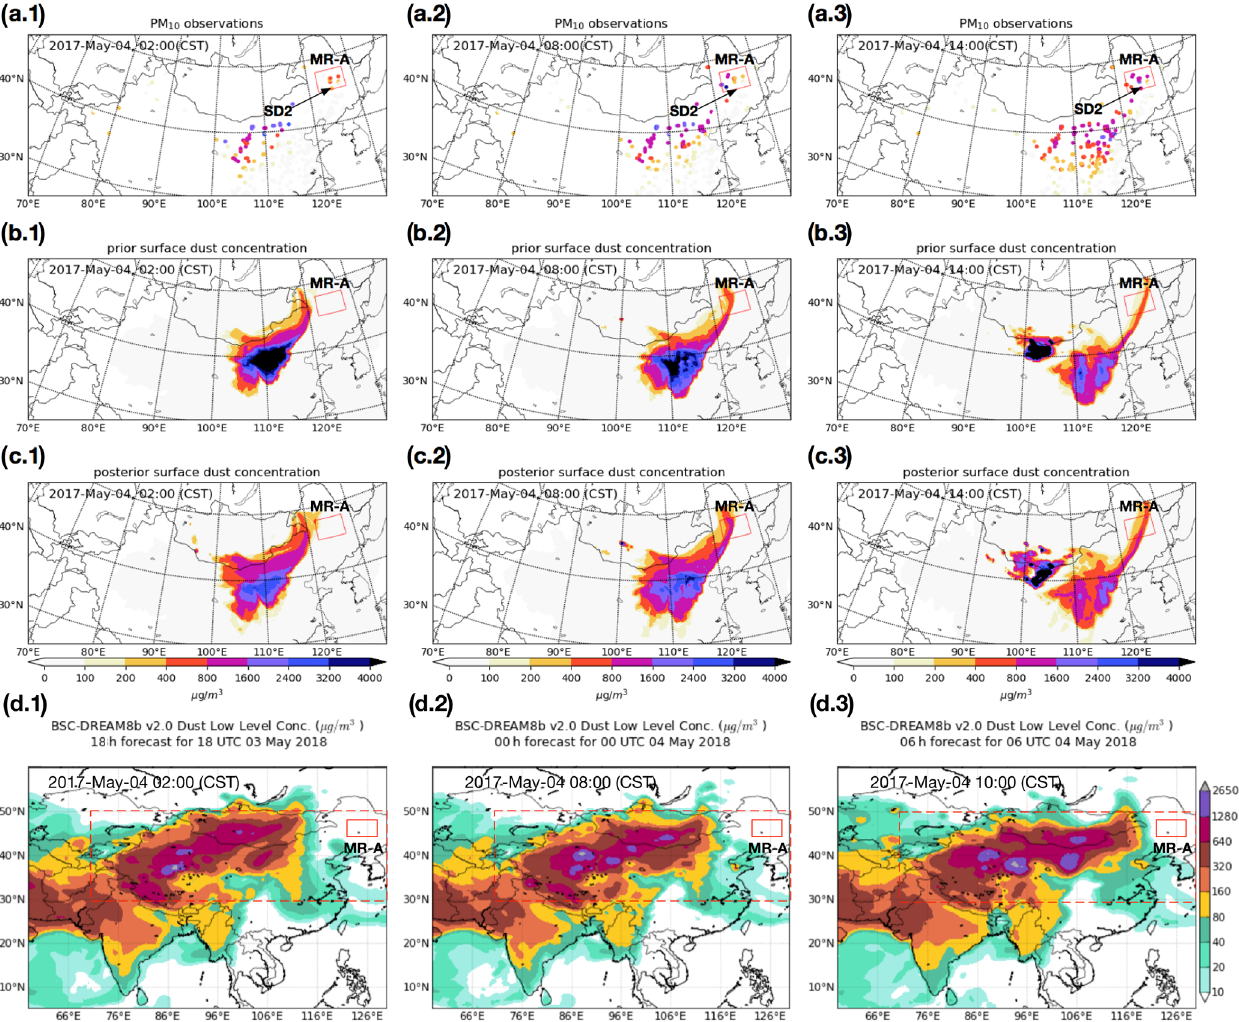
Figure 6. PM 10 observations and surface dust concentrations simulated for the second severe dust event (SD2) for 4 May, 02:00 (CST) (a.1–d.1) , 08:00 (a.2–d.2) , and right column 14:00 (a.3–d.3) . Top row PM 10 observations (a.1–a.3) , second row prior simulations (b.1–b.3) , third row posterior simulations (c.1–c.3) , and bottom row BSC-DREAM8b simulations (d.1–d.3) . MR-A: marked region